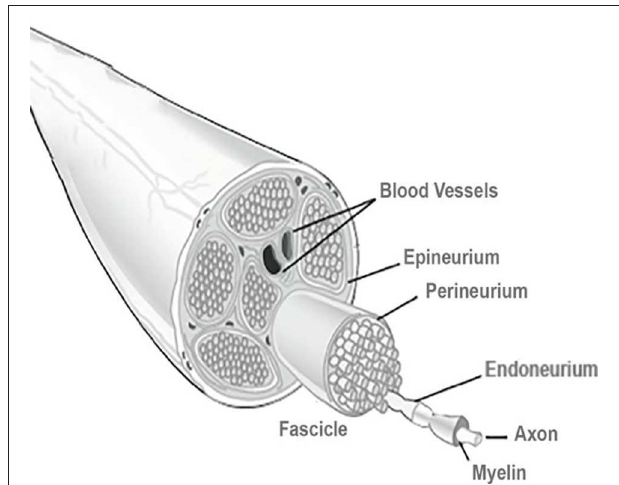
FIGURE 1 | Basic anatomy of a peripheral nerve. A connective tissue layer, endoneurium, involves the individual axons. An arrangement of axons, designed fascicles, is surrounded by the perineurium, and groups of fascicles are separated by the epineurium. External to this layer is the blood supply derived from major arteries and the latter is involved by the mesoneurium. Reproduced with permission from Pedrosa et al. (2016).